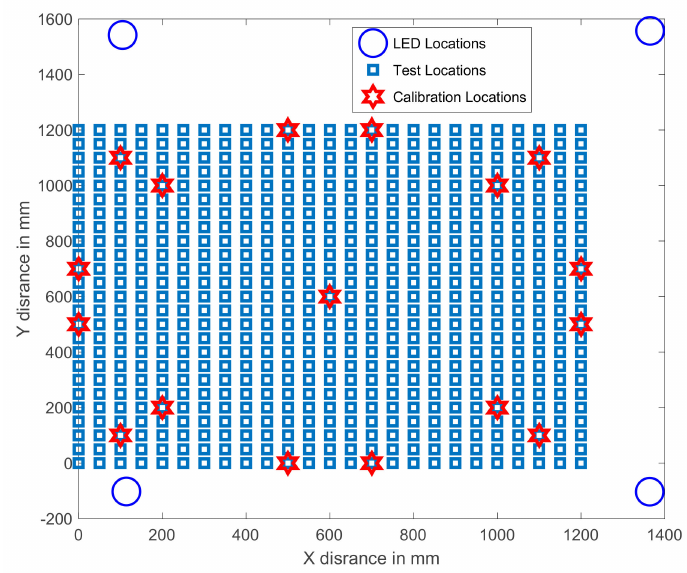
Figure 15. Measurement locations and test setup for the VLP system.